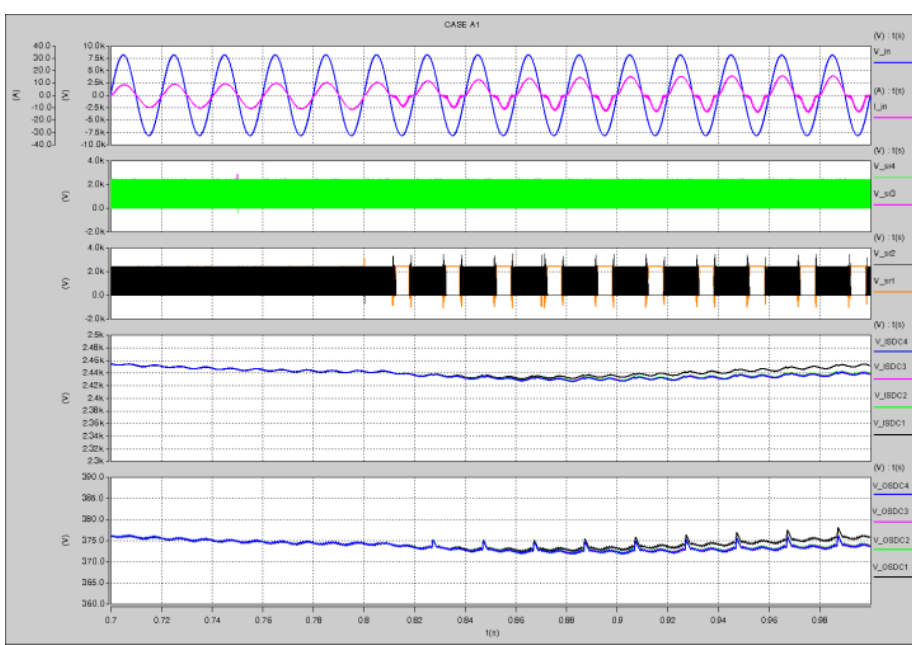
Figure 12. Simulation results of fault A1.